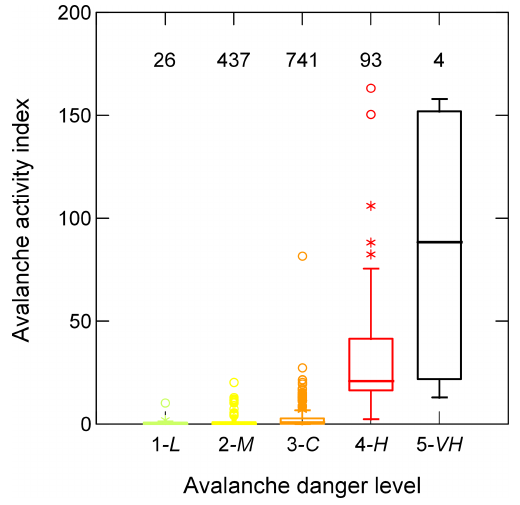
Figure 2. Avalanche activity index (AAI) per danger level (1-Low, to 5-Very High). Only days with AAI > 0 are included. Numbers indicate number of days per danger level; total number of days: N =